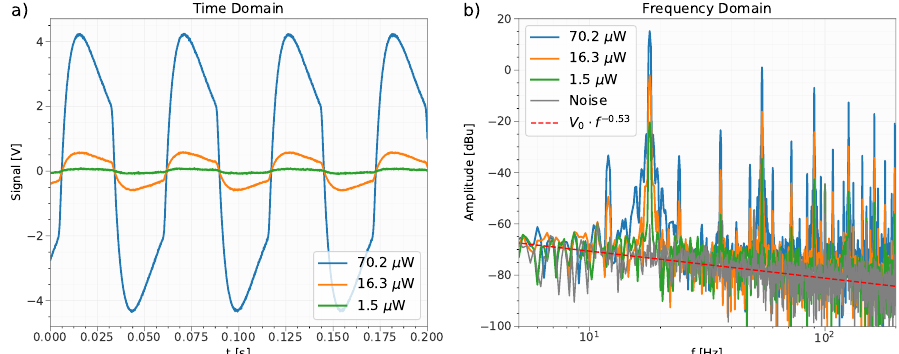
Figure 6. The voltage response of the pyroelectric detector is exposed to modulated infrared radiation P 0 . ( a ) Time domain signals. ( b ) Frequency domain signals together with a recorded noise signal (i.e., no incident radiation), the f − 0.53 decrease in the amplitude corresponds to a PSD dependence in f − 1.05